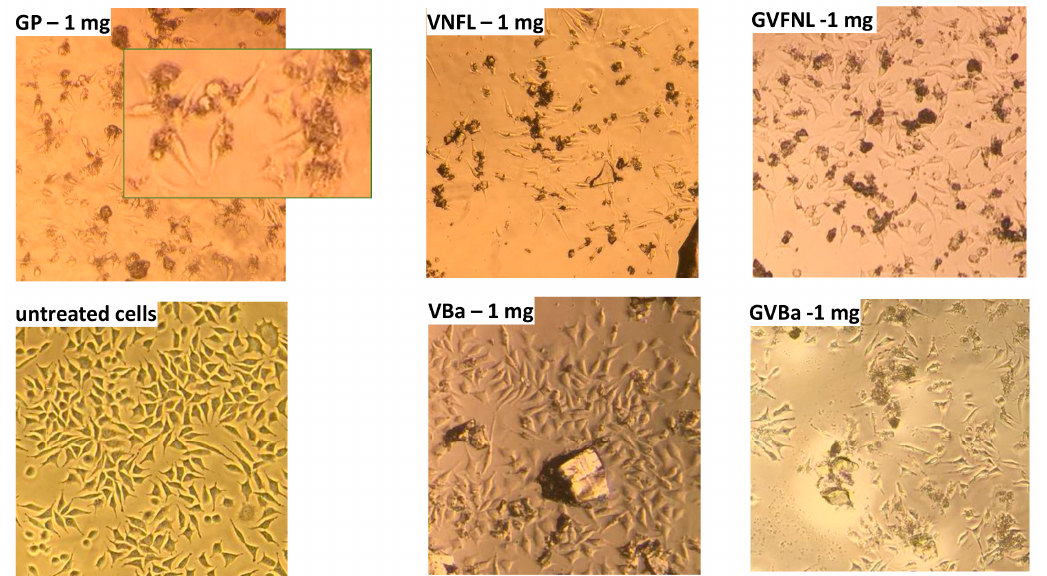
Figure 5. Morphological changes in NIH-3T3 cells treated with different waste glasses. Representative images were acquired by an Inverted Phase Contrast Brightfield Zeiss Primo Vert Microscope.